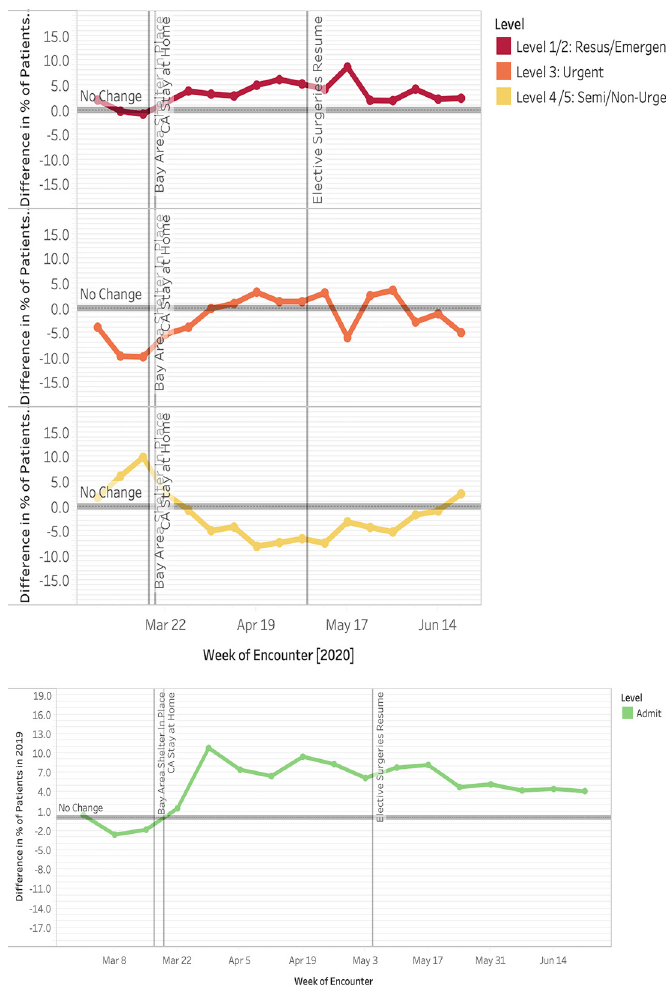
Figure 6. Change in proportion of patients by acuity as measured by Emergency Severity Index (ESI) level for weekly emergency department (ED) visits and percent change by admissions for weekly ED visits in 2020 (top) compared to 2019 (bottom)